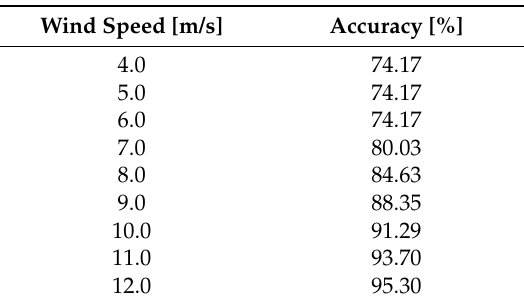
Table 1. The probability that outputs exist within a tolerance band.